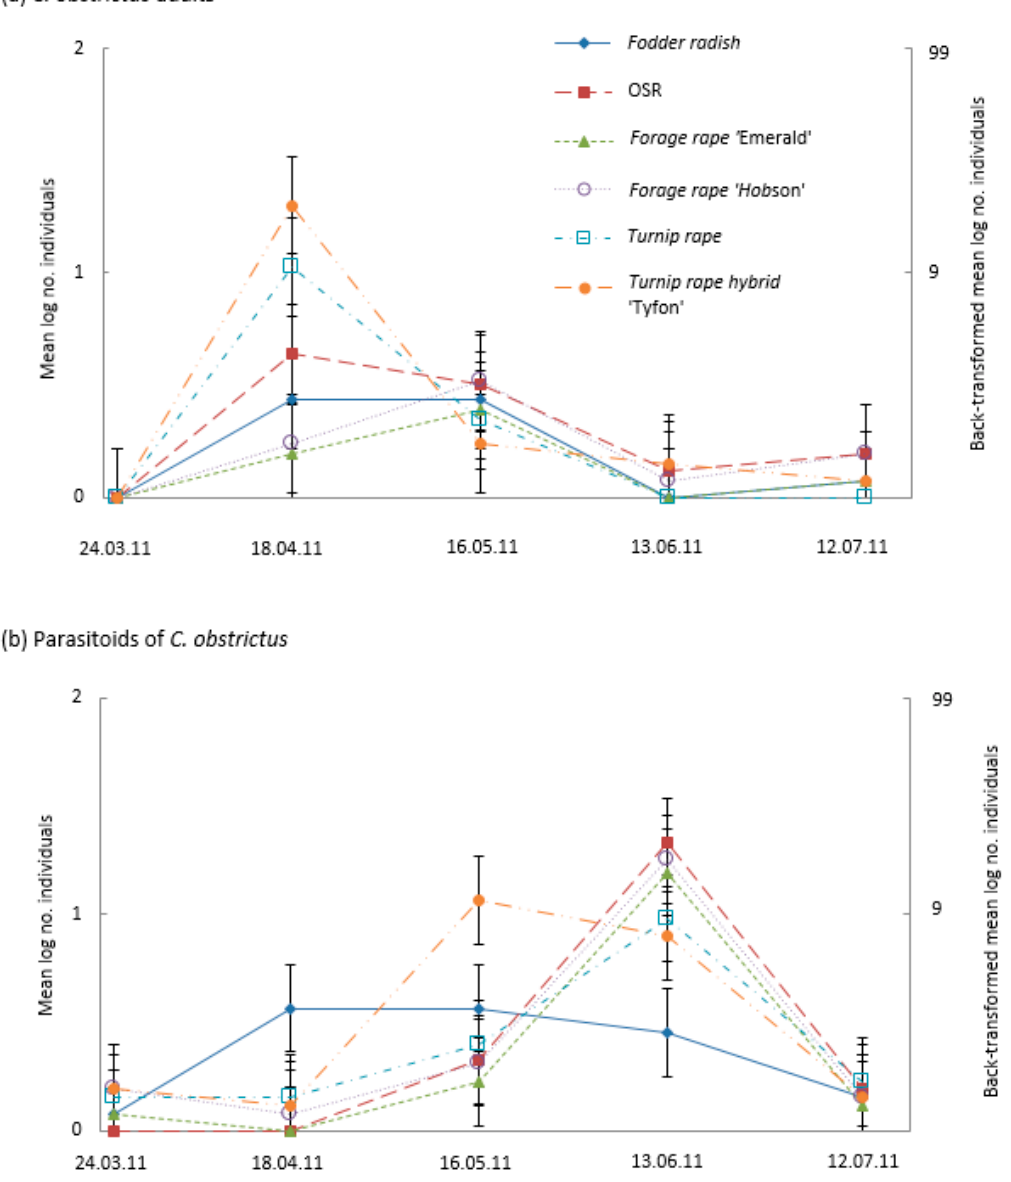
Figure 3. Mean numbers (log scale—left axis and back-transformed –right axis) of cabbage seed weevil Ceutorhynchus obstrictus ( a ) adults and ( b ) parasitoids in suction samples taken monthly from plots ( n = 4) of different Brassicaceae: Fodder radish ( Raphanus sativus ) cv Apoll; Oilseed rape (OSR, Brassica napus ) cv Castille; Forage rape ( Brassica napus ) cv Emerald and cv Hobson; Turnip rape ( Brassica rapa ) cv Jupiter and Tyfon (a hybrid of B. rapa Rapifer group × B. rapa Pekinensis group). CIs (vertical bars) are valid for within-date comparisons; for between-date comparisons, CIs should be based on SEM values of ( a ) 0.1022 and ( b ) 0.0999.